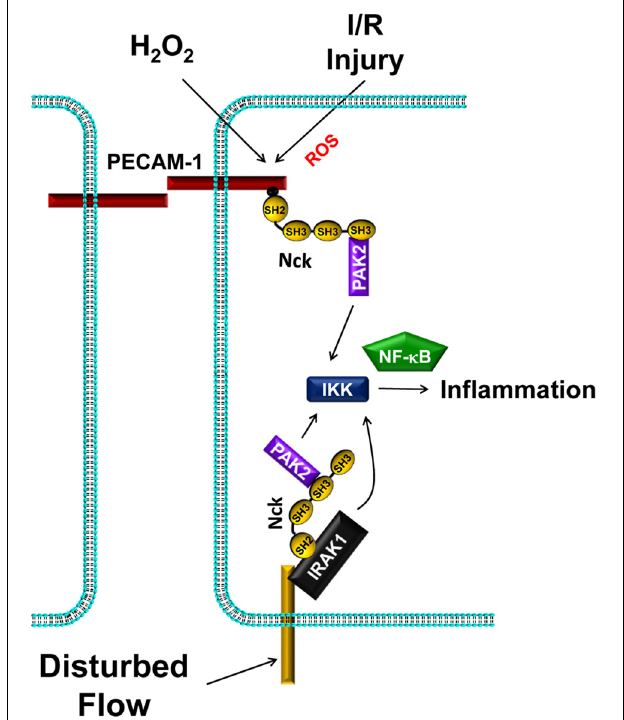
FIGURE 5 | Nck1/2 recruitment to tyrosine phosphorylated proteins promote IKK-dependent NF- κ B activation and proinflammatory gene expression. Oxidative stress (H2O2, ischemia/reperfusion injury) promotes Nck1/2 recruitment through PECAM-1 phosphorylation. In disturbed flow, Nck1 recruitment to IRAK-1 promotes NF- κ B activation through a pathway that may or may not involve